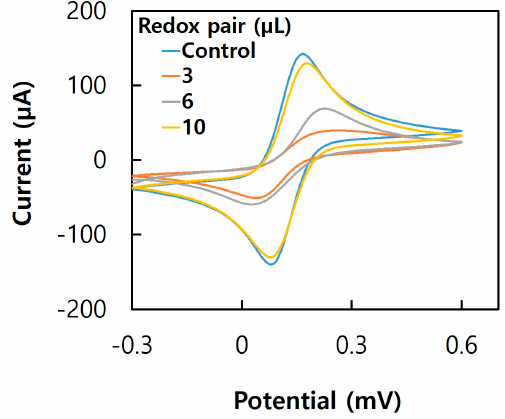
Figure 6. Cyclic voltammograms obtained by applying 20 µL of 0.1 × PBS (pH 7.4) to the asymmetric-membrane-attached electrodes depending on added amount of the redox pair.